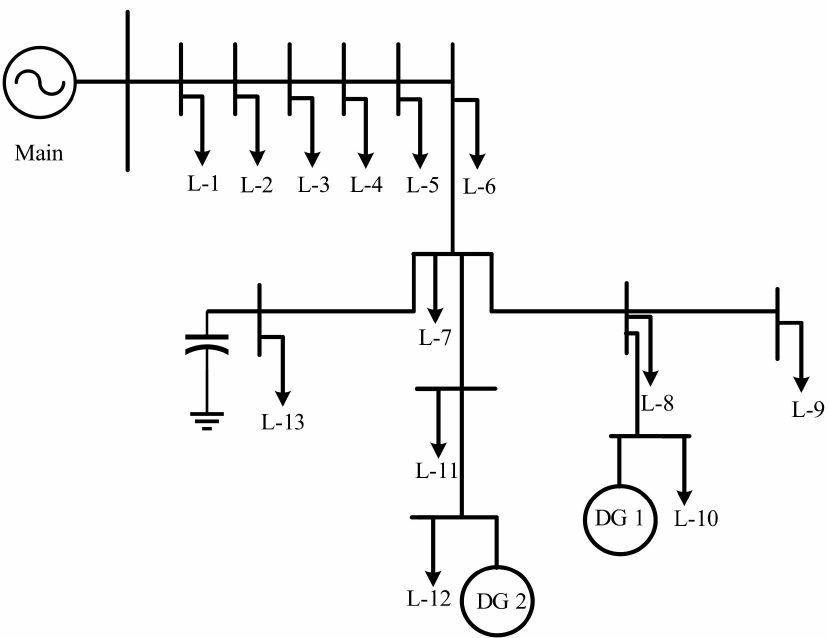
Figure 5. IEEE 13-bus distribution test feeder.